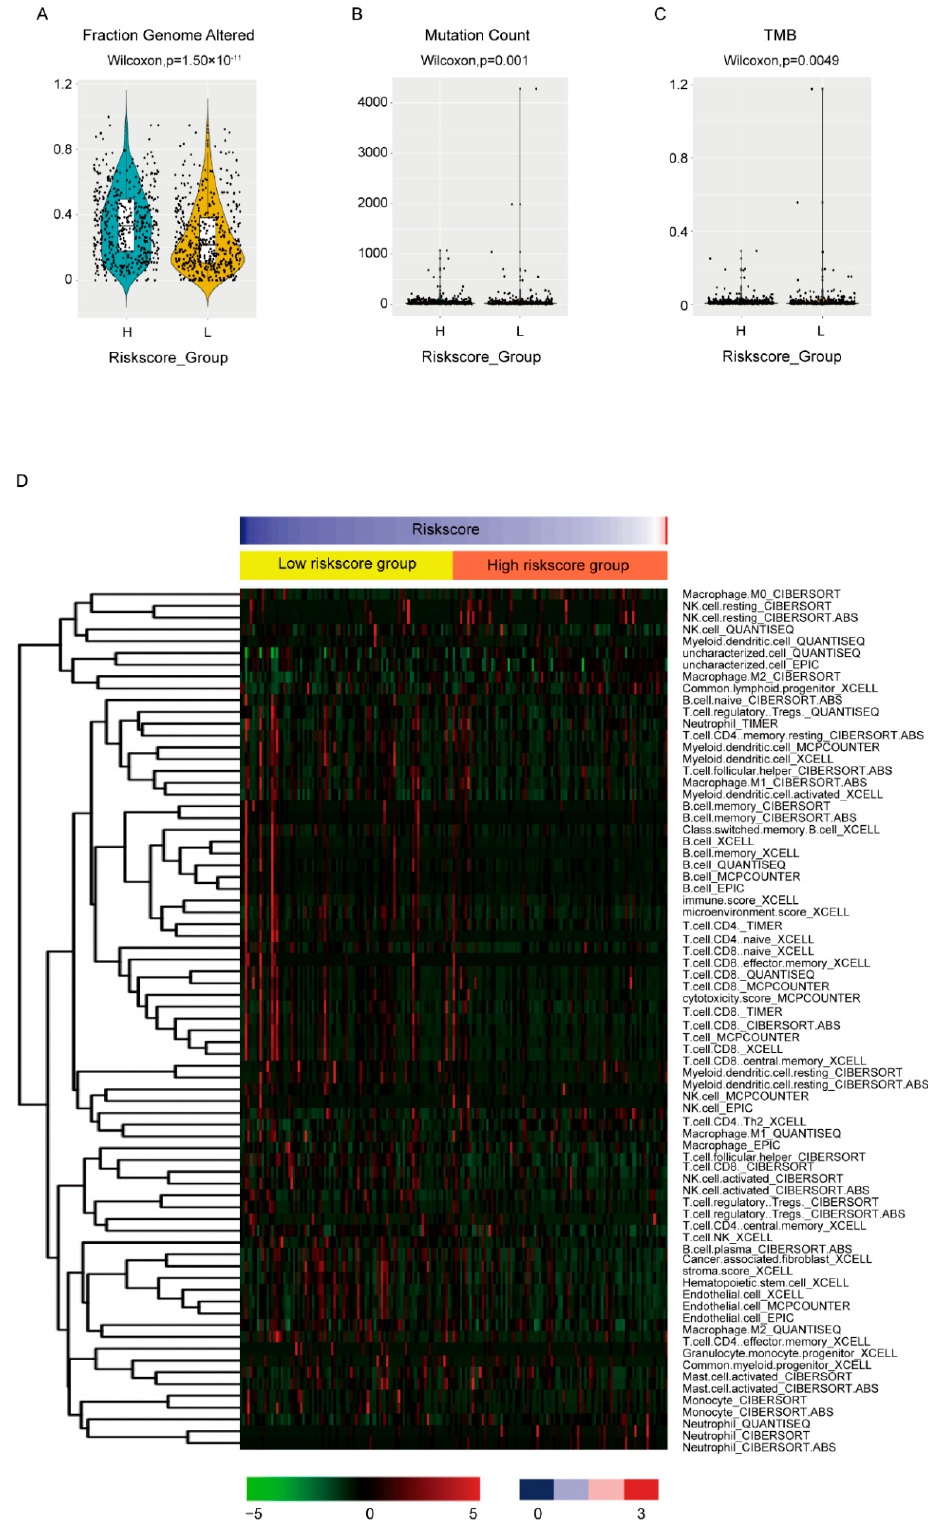
Figure 6. Association between the risk score and biological features. The fraction genome altered ( A ), mutation count ( B ), TMB ( C ) and the estimated immune infiltrations ( D ) were compared between high- and low-risk score groups by Wilcoxon test. Only cell types differentially distributed between groups were shown in ( D